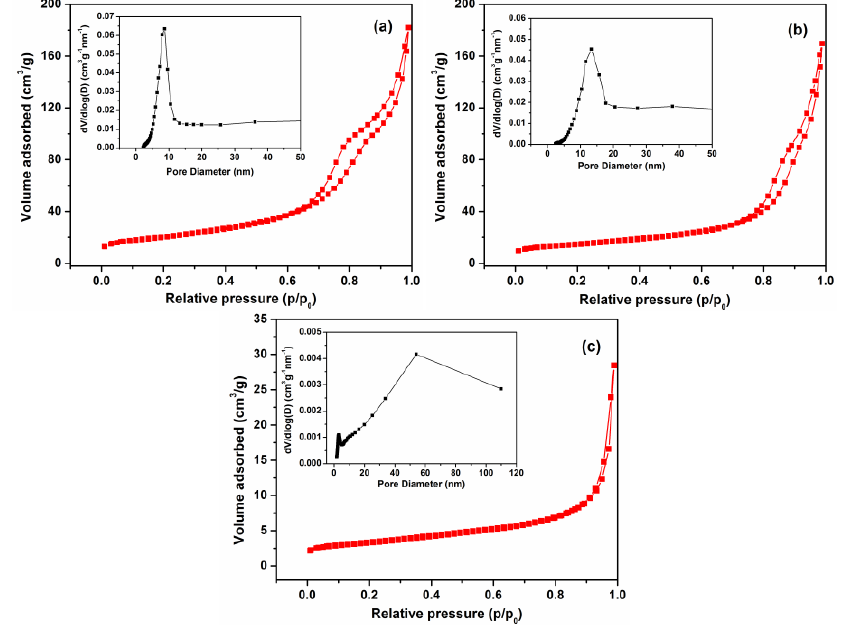
Figure 5. Typical N gas adsorption-desorption isotherm of the F3, F5 and commercial 2 ZnO samples. Insets: the corresponding pore-size